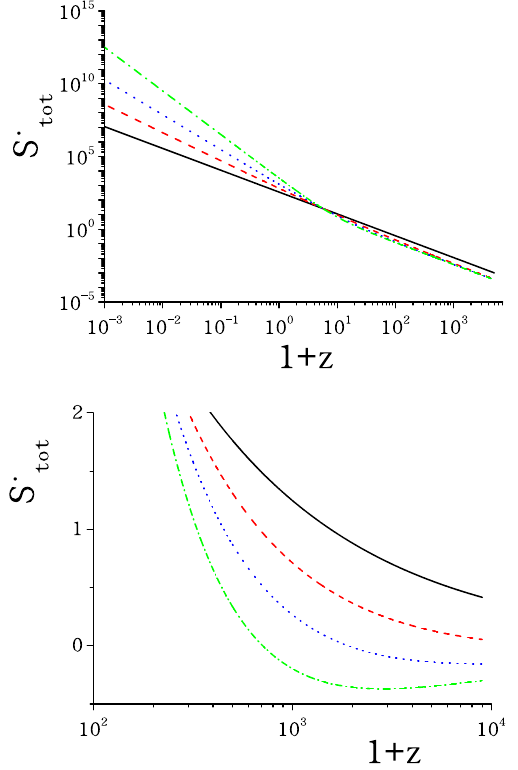
Fig. 2 The evolution of the entropy time-variation as a function of the redshift z given by (23), in the case of power-law background evolution (25), for various values of the Barrow exponent (cid:2) . Upper panel: n = 2 / 3 and (cid:2) = 0 (black—solid), (cid:2) = 0 . 3 (red—dashed), (cid:2) = 0 . 6 (blue—dotted), (cid:2) = 1 (green—dashed-dotted). Lower panel (mind the difference in the axes): n = 2 and (cid:2) = 0 (black—solid), (cid:2) = 0 . 3 (red—dashed), (cid:2) = 0 . 6 (blue—dotted), (cid:2) = 1 (green—dashed- dotted). We have imposed (cid:8) m 0 = 0 . 30 and (cid:8) r 0 = 10 − 4 , and we have used units where ¯ h = k B = c = 1 = H 0 =